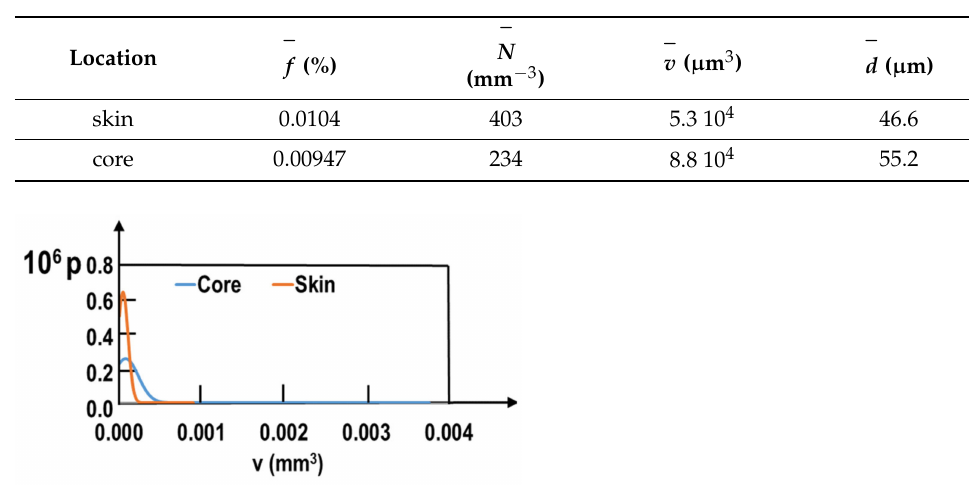
Table 5. Mean values of the porosity distribution in the skin and the core of the ingot. f and N correspond, respectively, to the mean void volume fraction and number of voids per unit volume. v and d designate, respectively, the mean void (micro-shrinkage) volume and diameter.